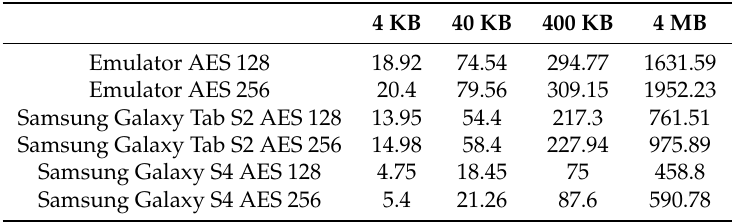
Figure 9. Policy based on Bluetooth device presence and network messages. ( a ) Access denied; ( b ) Access granted. Table 5. Average encryption time for several file sizes